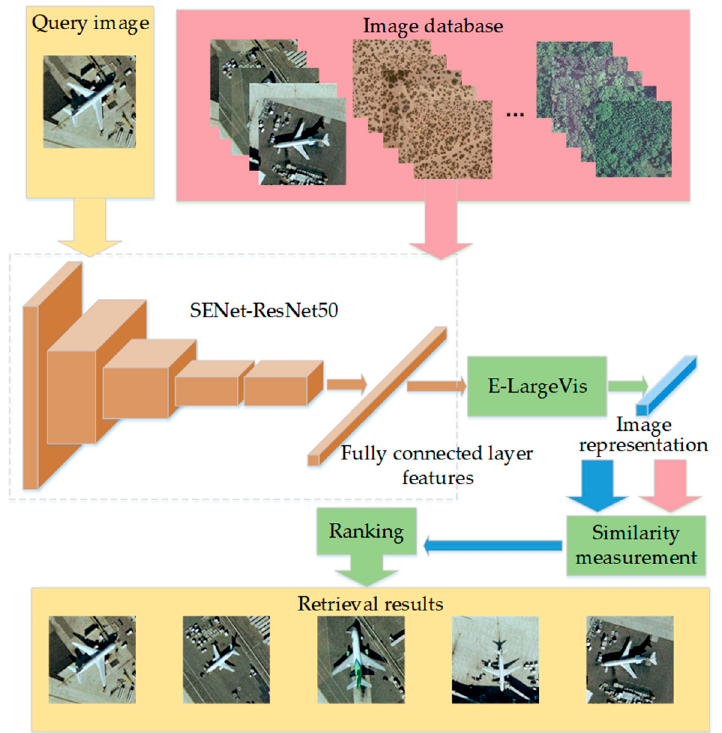
Figure 5. Channel attention-based high-resolution RSIR. Firstly, the fully connected layer features are extracted by SENet-ResNet50. Then, Extended LargeVis (E-LargeVis) was used to reduce the dimensionality of the features to obtain a low-dimensional discriminative representation. Finally, L2 distance was computed to measure similarity and realize the retrieval of high-resolution remote sensing images.